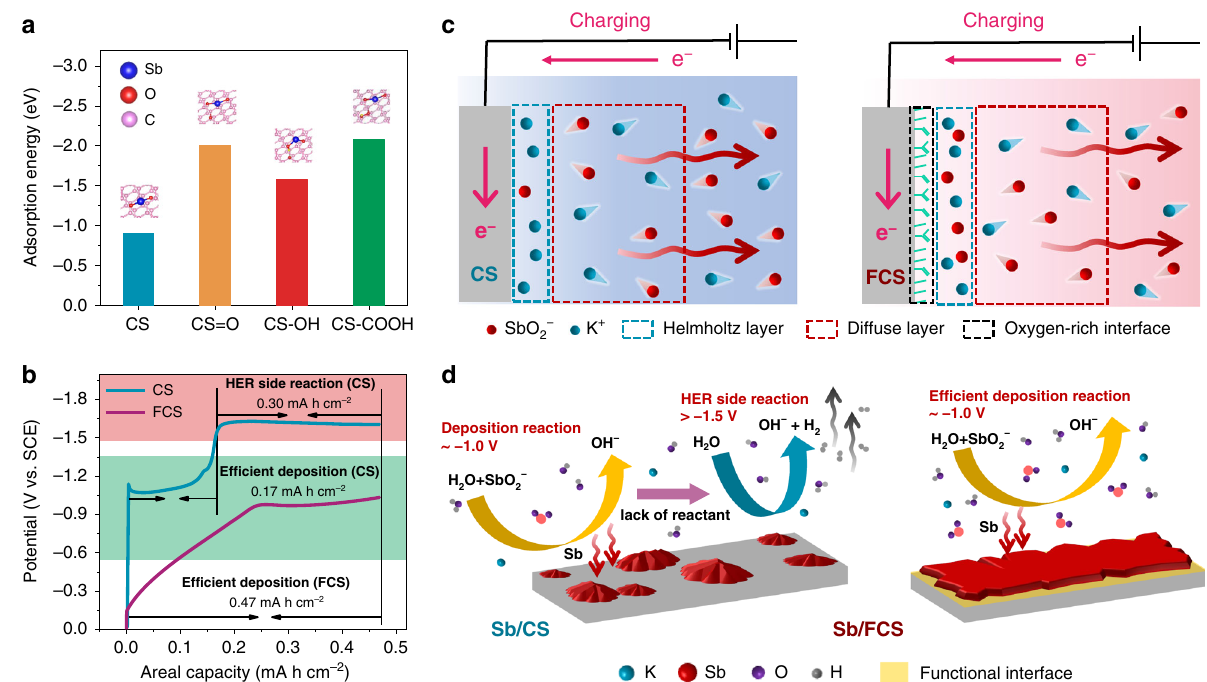
Fig. 3 Comprehension of oxygen-rich interface induced reversible stripping/plating process. a Relative SbO 2 − absorption energy pro fi les of the CS surface with different functional groups. b Electroplating curve of the Sb on the substrates at 20mAcm − 2 with a fi xed charging capacity of 0.47mAh cm − 2 . c Illustration of the ion distribution during the plating process of CS and FCS. The arrows indicate the direction of SbO 2 − diffusion. d The plating mechanism on the substrate with/without the functional interface Fig. 21, with respect to the CS, the pro fi le of FCS delivers a smoother voltage dip and a much lower nucleation overpotential (from 147 to 29 mV), suggesting the oxygen-rich functional interface can dramatically lower the resistance for Sb nucleation and is more favorable for Sb deposition. Brie fl y, the FCS inte- grates the strong absorption capability of the SbO 2 − and the lower Sb nucleation overpotential, which conjointly contribute to the suppression of side reactions and the high ef fi ciency of Sb stripping/plating.